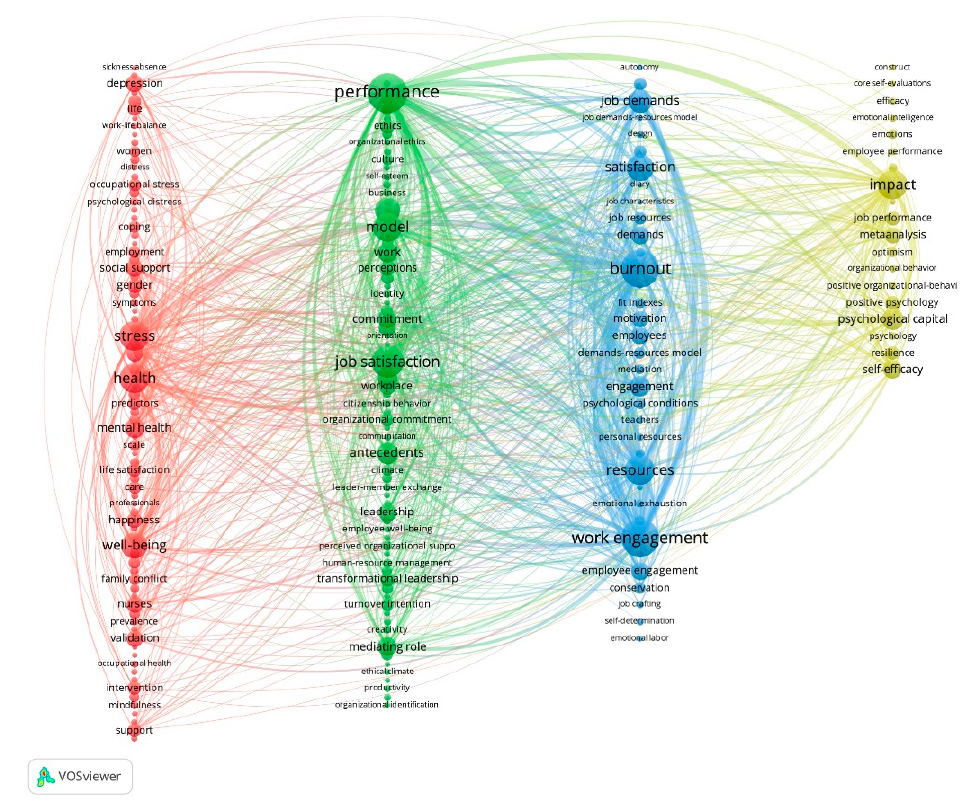
Figure 7. Diagram of keyword